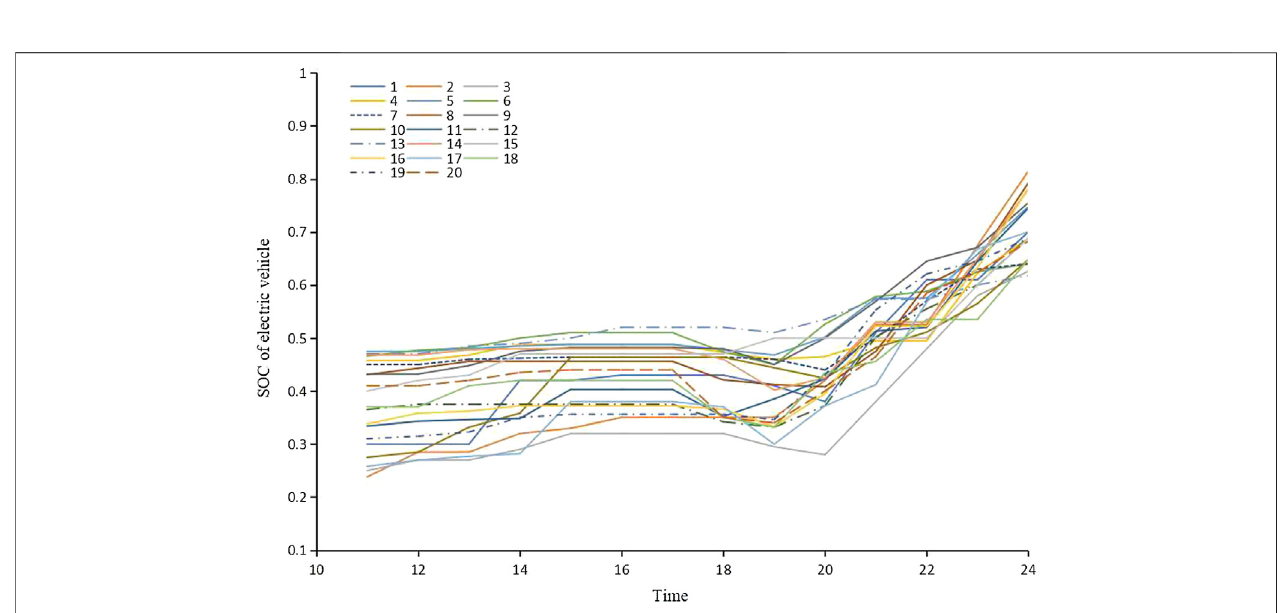
FIGURE 5 | SOC of electric vehicles after collaborative management and